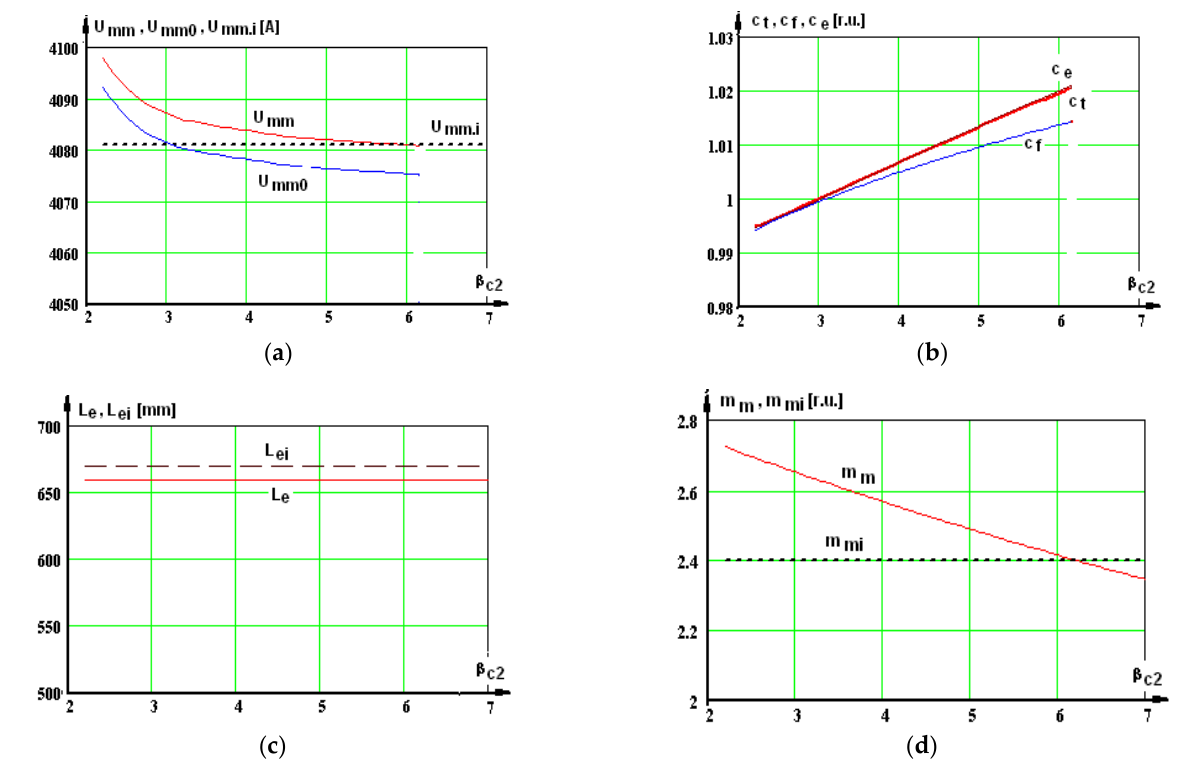
Figure 5. Variation curves relative to the variable β c 2 —shape factor of the rotor slot for: ( a ) total ampere-turn for a pole pair U mm 0 / U mm / U mm.i —for the optimized machine/real machine/imposed value; ( b ) c t / c f / c e —total/fabrication/exploitation costs; ( c ) total length; and ( d ) maximum torque.